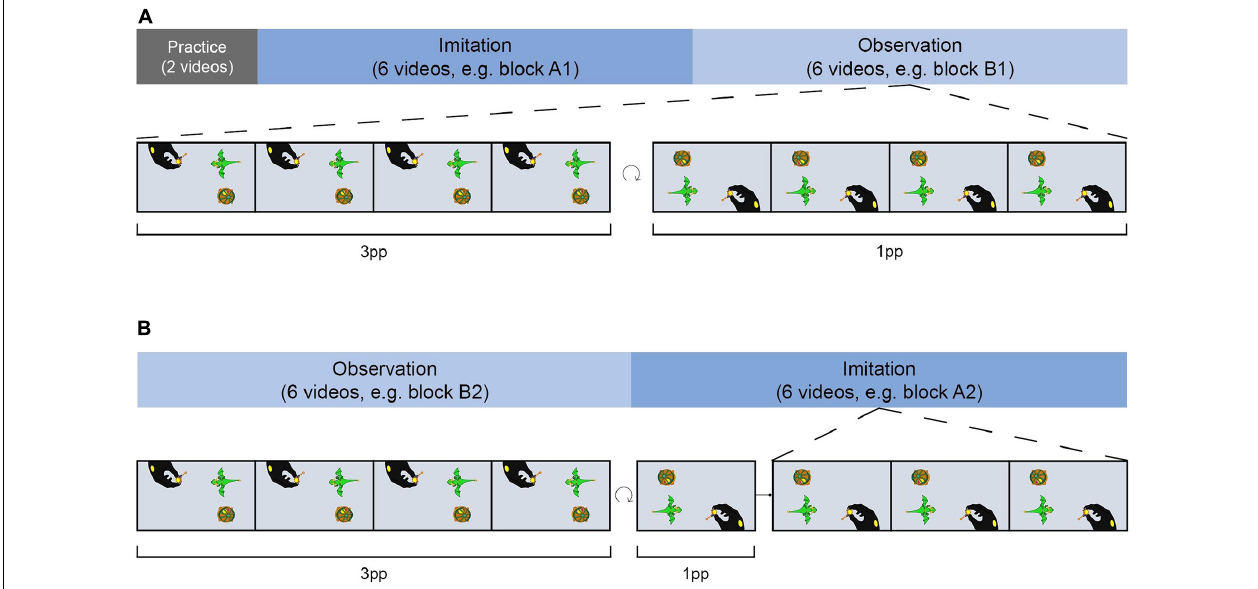
FIGURE 3 | Training procedure. Training took place on two consecutive days. Half of the actions were imitated and the other half were only observed by participants. Imitation and observation videos were presented within blocks of six videos each. (A) After a short practice on the first day, participants either started the training with an imitation block on the first (A) and an observation block on the second day (B) or vice versa. In the imitation block, each demo video was presented four times from 3pp and one time from 1pp before participants had to accurately imitate each action three times. During observation blocks, participants were presented with demo videos four times from 3pp and four times from 1pp. At the end of each trial, participants had to provide a detailed description of the action story.